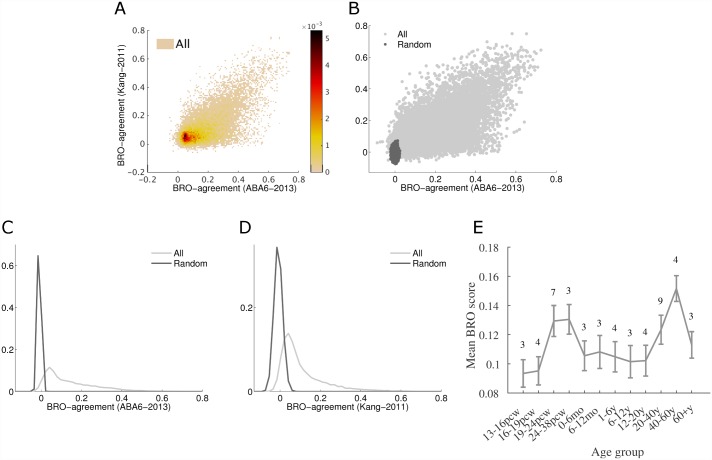
Distribution of BRO-agreement scores of individual genes.(A) Heatmap showing the joint distribution of BRO-agreement scores of all genes in 16 regions of ABA6-2013 (absica) and Kang-2011 (ordinate). Colors correspond to the density. (B) A scatter plot showing BRO-agreement scores for the two datasets in A. Each light-grey dot corresponds to a single gene (a total of 17K genes). Dark-grey dots correspond to permuted data (see Methods). The BRO scores are significantly correlated across the two datasets (Spearman, ρ = 0.53, n = 16947, p-value<10−16). (C) Marginal distribution of BRO scores in the ABA6-2013 dataset. BRO scores for most genes are significantly greater than randomized scores. (D) Same as C, for the Kang-2011 data. (E) BRO-agreement scores traced through life based on the full developmental dataset in Kang-2011. Samples are aggregated based on the developmental stages defined in [6]. Numbers above the line denote the number of subjects in each age group.